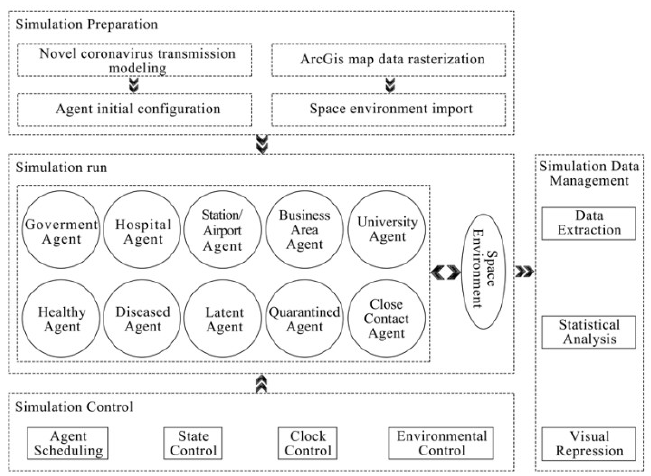
Figure 5. System operation